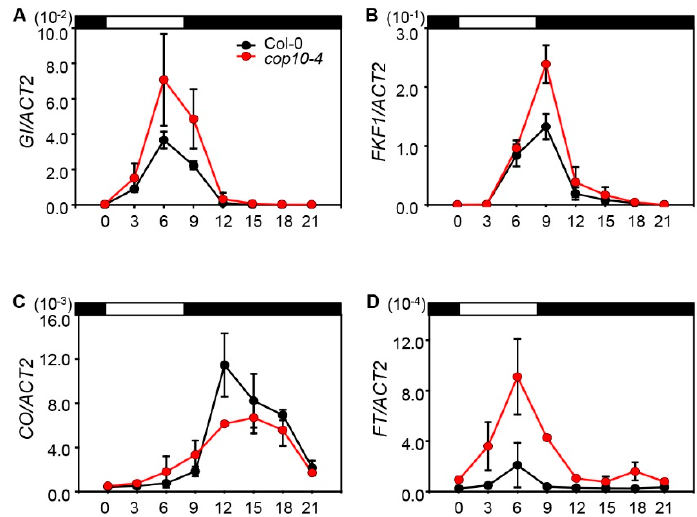
Figure 2. Effect of cop10-4 on GIGANTEA ( GI ), F-BOX PROTEIN1 ( FKF1 ), CONSTANS ( CO ), and FLOWERING LOCUS T ( FT ) expression under short days (SD). The expression of GI ( A ); FKF1 ( B ); CO ( C ); and FT ( D ) was analyzed in Col-0 and cop10-4 mutants by real-time PCR using three-week-old plants. Plants were grown at 22 °C under SD (8-h light:16-h dark) conditions, and plant tissues were harvested every 3 h. ACT2 expression was used for normalization. Means and standard deviations were obtained from three biological replicates. These experiments were repeated twice with the same results.